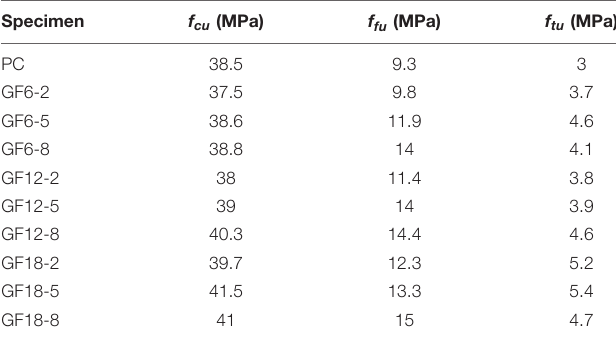
TABLE 2 | Strength of fine-grained concrete reinforced with AR-glass fibers (28 days).